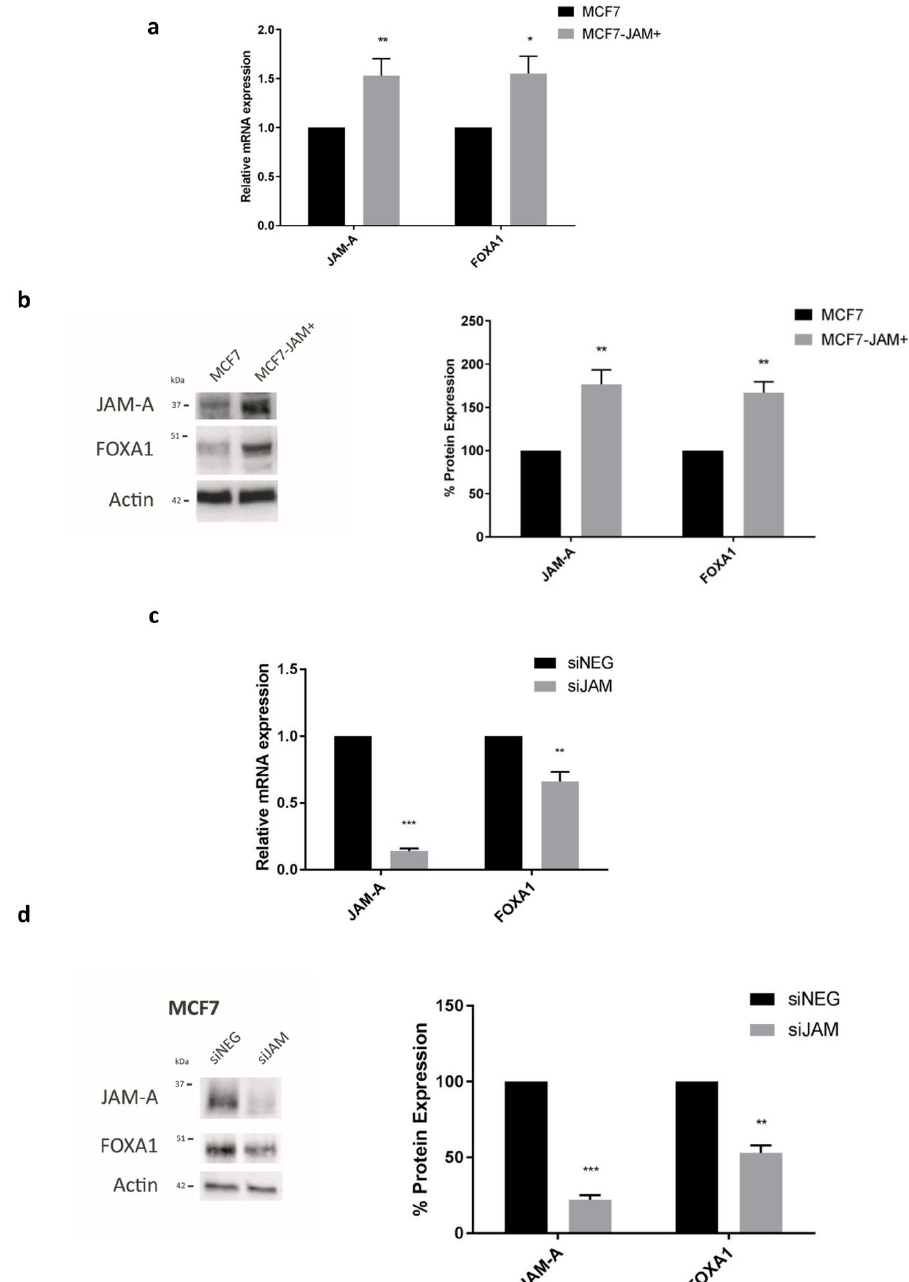
Figure 3. JAM-A influences mRNA and protein expression of FOXA1. RNA and protein from control MCF7 cells overexpressing empty vector (MCF7) and MCF7 cells overexpressing JAM-A (MCF7-JAM+); or MCF7 cells transfected with 25 nM control siRNA (siNEG) or a pool of JAM-A siRNA (siJAM) for 72 h were analyzed by qRT-PCR and immunoblotting. ( a ) Analysis of MCF7-JAM+ by RT-qPCR revealed significant upregulation of FOXA1 mRNA expression compared to that in wild type MCF7 cells. ( b ) Representative western blot image and densitometric analysis of JAM-A and FOXA1 normalized to actin revealed that overexpression of JAM-A in MCF7-JAM+ cells was associated with upregulation of FOXA1 protein expression compared to wild type MCF7 cells. ( c ) RT-qPCR revealed FOXA1 mRNA expression was significantly reduced after JAM-A knockdown compared to control conditions in MCF7 cells. ( d ) Representative western blot image and densitometric analysis of JAM-A and FOXA1 normalized to actin revealed that JAM-A gene silencing reduced FOXA1 protein expression compared to siNEG control in MCF7 cells. Experiments were performed three times and data represent mean ± s.e.m, compared using two-tailed, equal variance Student’s t -tests, * p < 0,05, ** p < 0.01, *** p <